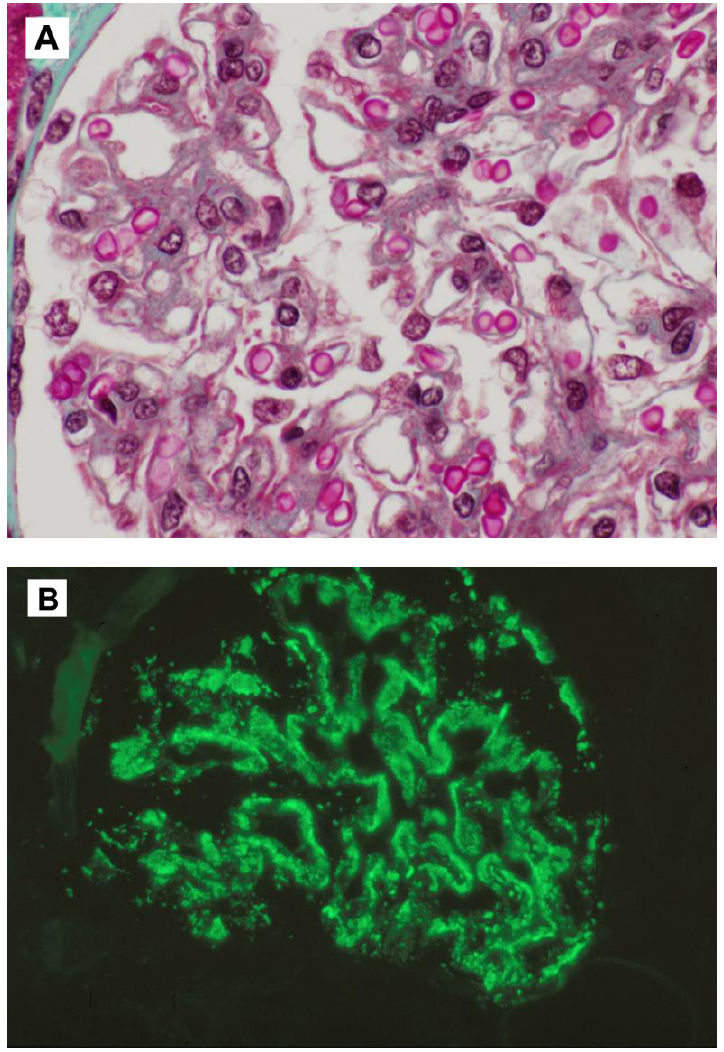
FIGURE 1 . (A) Light microscopy image showing segmental subepithelial fuchsinophilic deposits (hematoxylin eosin). (B) IF showing diffuse granular deposits of